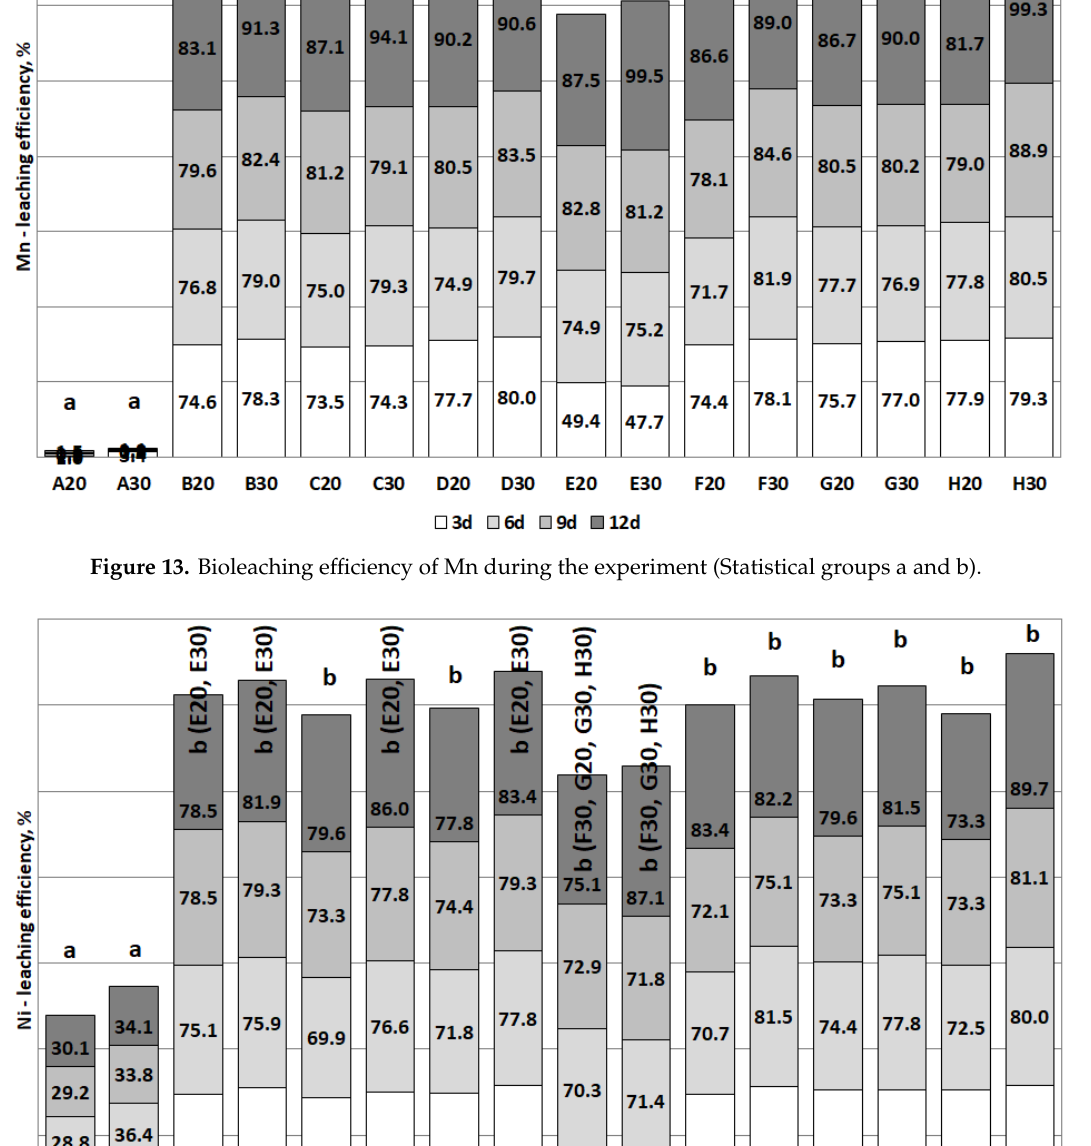
Figure 14. Bioleaching efficiency of Ni during the experiment (Statistical groups a and b ).